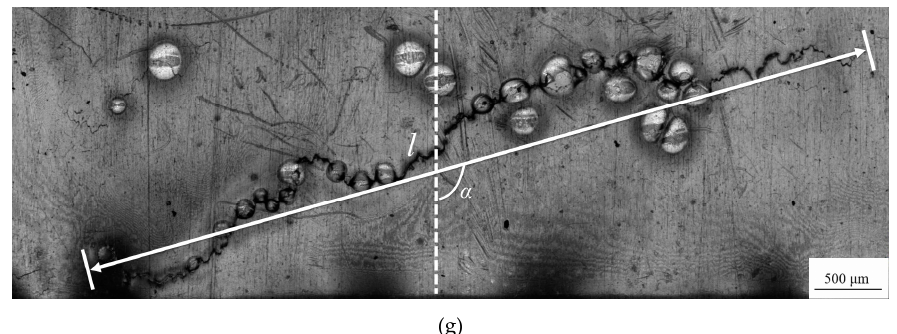
Figure 4. Replica photos for specimen TC2 under different number of cycles: ( a ) N = 0 cycles; ( b ) N = 200 cycles; ( c ) N = 4,000 cycles; ( d ) N = 14,000 cycles; ( e ) N = 30,000 cycles; ( f ) N = 53,000 cycles; ( g ) N = 59,000 cycles.